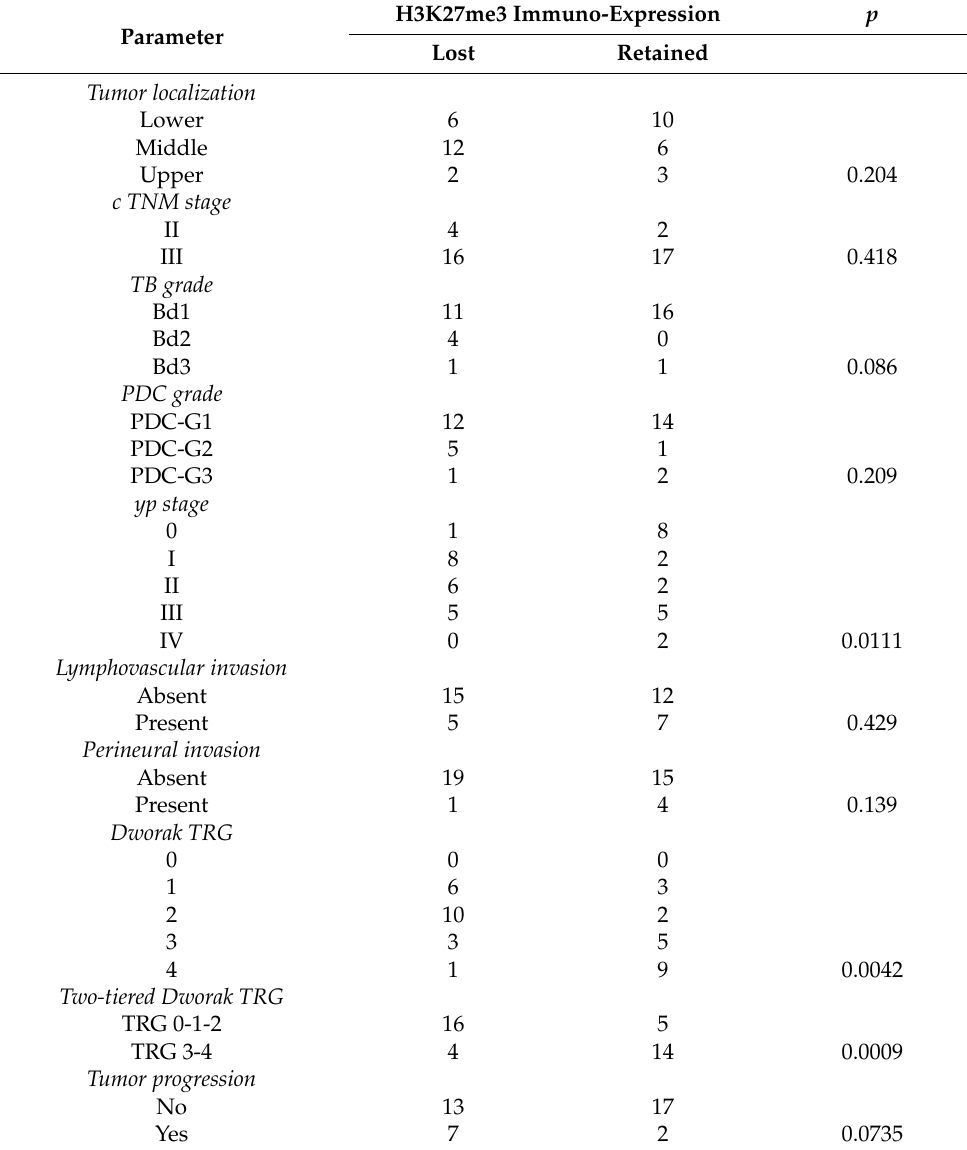
Table 1. Statistical correlations between H3K27me3 immunoexpression and clinical-pathological features of 39 rectal adenocarcinomas treated with neoadjuvant chemo-radiotherapy and